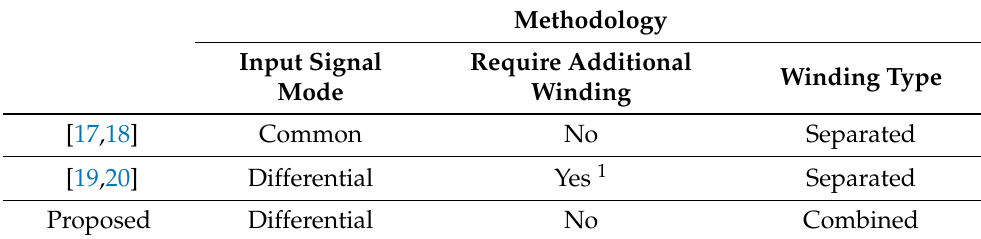
Figure 1. Four-pole, six-slot, combined winding self-bearing machine. Table 1. HFI spatial position self-sensing methods